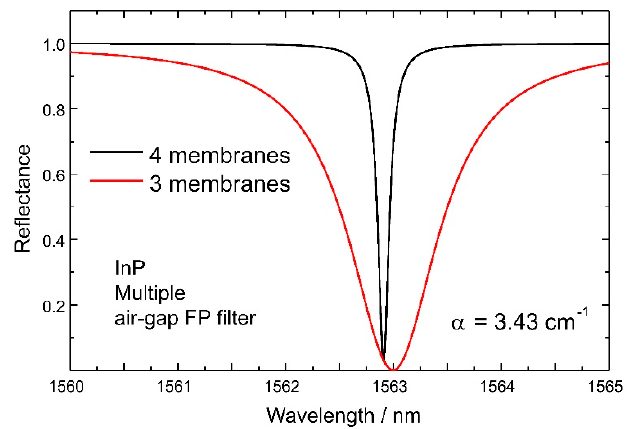
Figure 20. Transfer-matrix model calculations of InP multiple air-gap FP filter line spectra with DBRs including 3 and 4 InP membranes each.